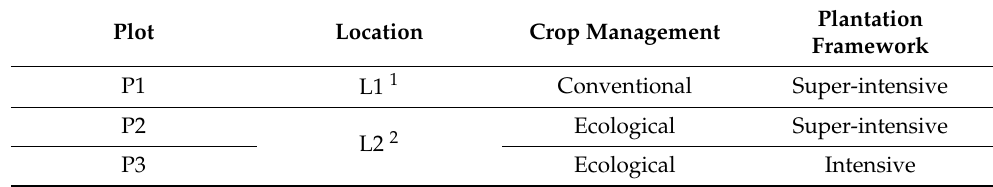
Table 1. Summary of the different Arbequina plots and agronomic conditions subject of study. Plot Location Crop Management Framework P1 L1 1 Conventional Super-intensive P2 Ecological Super-intensive L2 2